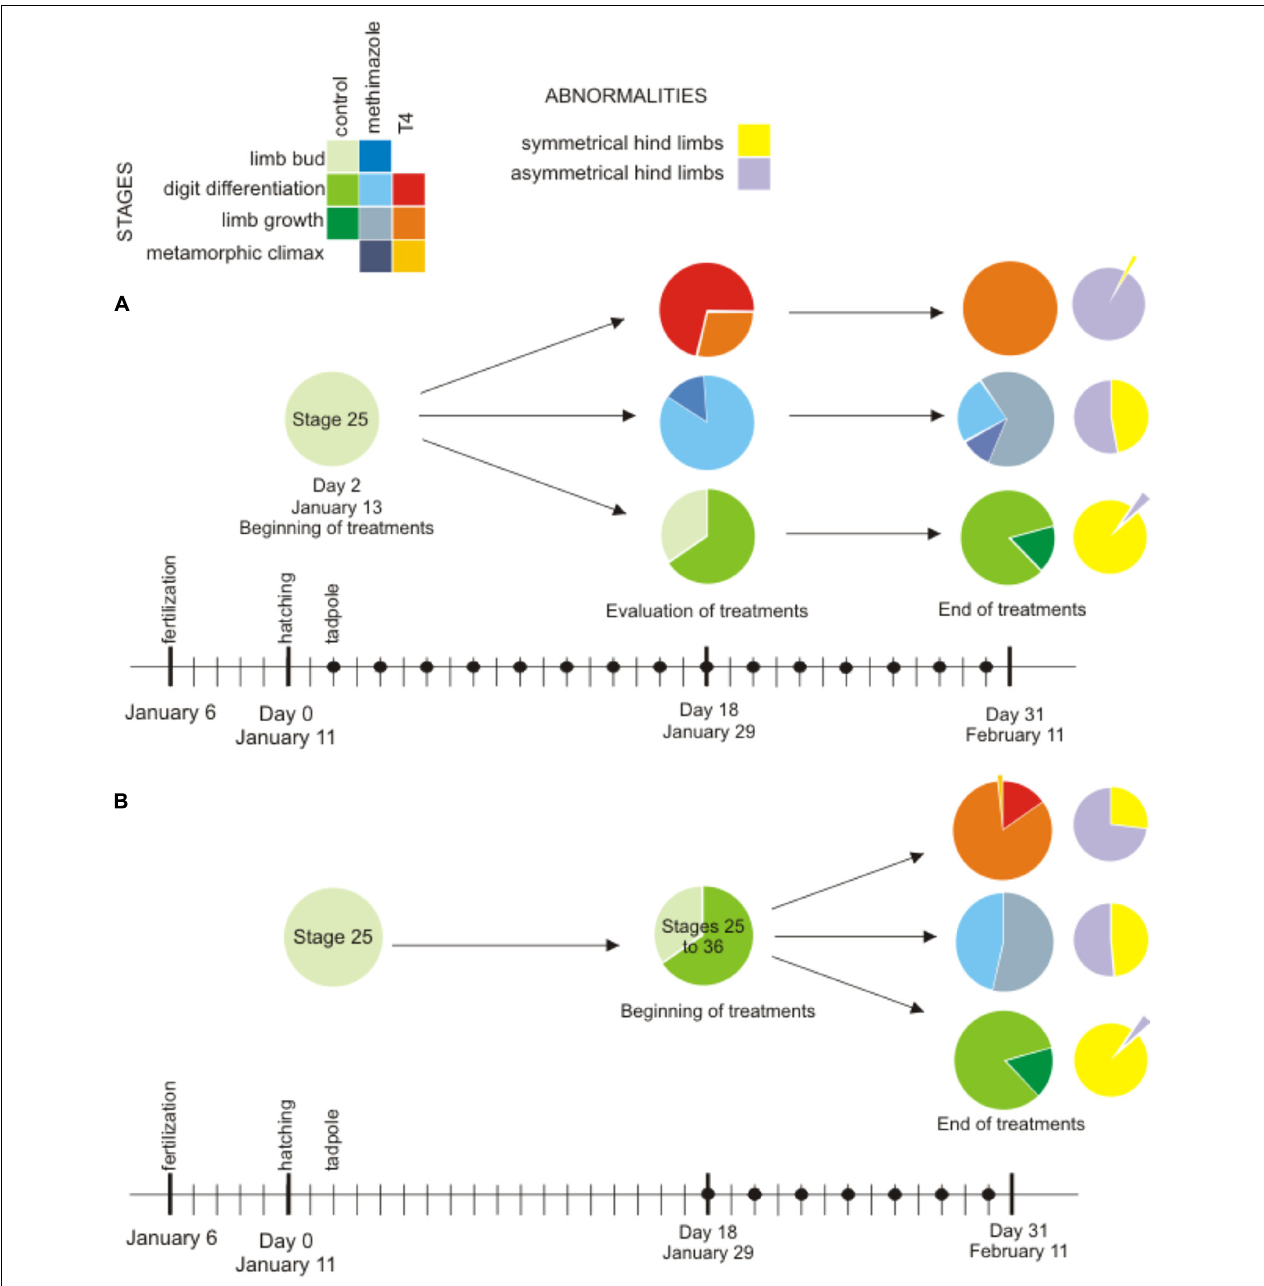
FIGURE 5 | Proportion of differentiation stages of tadpoles during the experiments: premetamorphosis [limb bud stages (Gosner 25–30) and digit differentiation (Gosner 31–36)], prometamorphosis [limb growth (37–41)] and metamorphic climax (42–46) and proportion of abnormalities (identified as hind limbs asymmetries in violet, and normal in yellow) at the end of experiments. (A) Early exposure: control in green circles ( N = 28 at 18 days after hatching; N = 60 at 31 days after hatching) with one specimen with abnormal limbs (violet); methimazole in blue circles ( N = 27 at 18 days after hatching, N = 47 at 31 days after hatching), abnormalities appear in the half of tadpoles; and T4 in red and orange circles ( N = 28 at 16 days of exposure, N = 61 at 29 days of exposure), almost all tadpoles present abnormalities (violet) (B) Late exposure: control in green circles ( N = 60 at 31 days after hatching), methimazole in blue circles ( N = 47 after 14 days of exposure), abnormalities appear in the half of tadpoles, and T4 in red-orange circles ( N = 61 after 14 days of exposure), abnormalities appear in 75% of tadpoles. Black dots indicate doses.